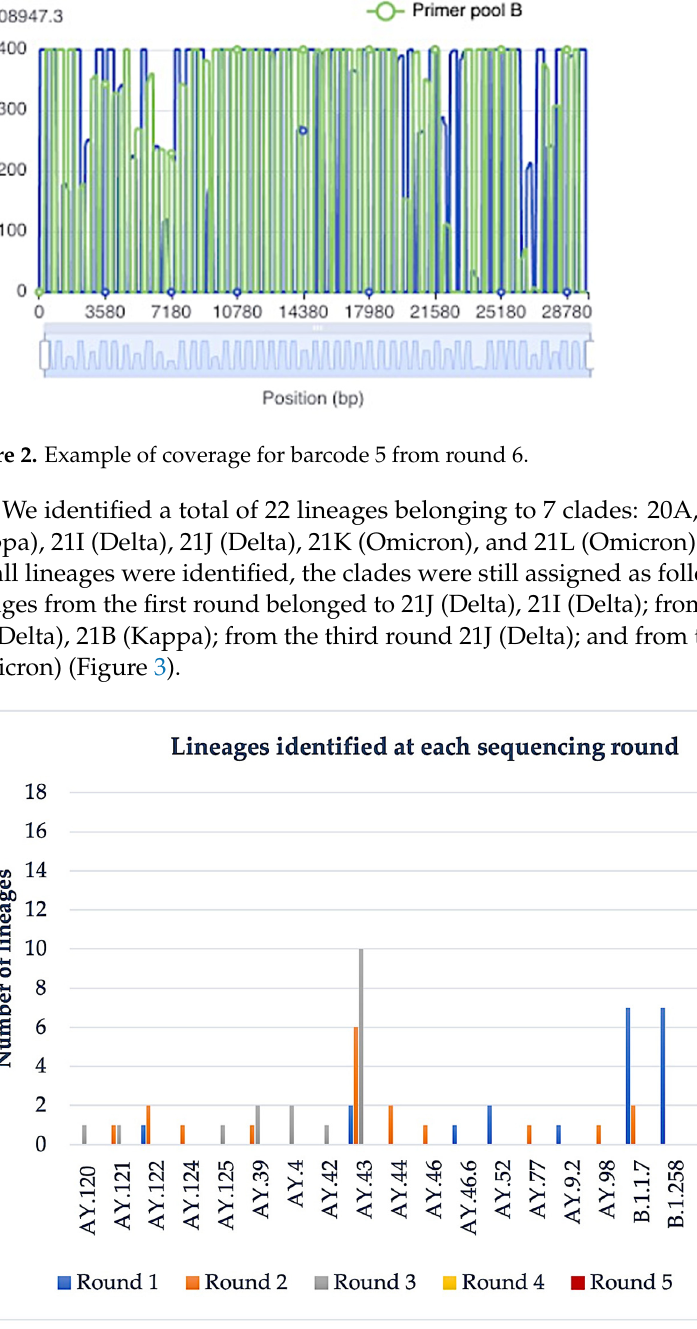
Figure 3. Lineage distribution in the six rounds of Nanopore sequencing.